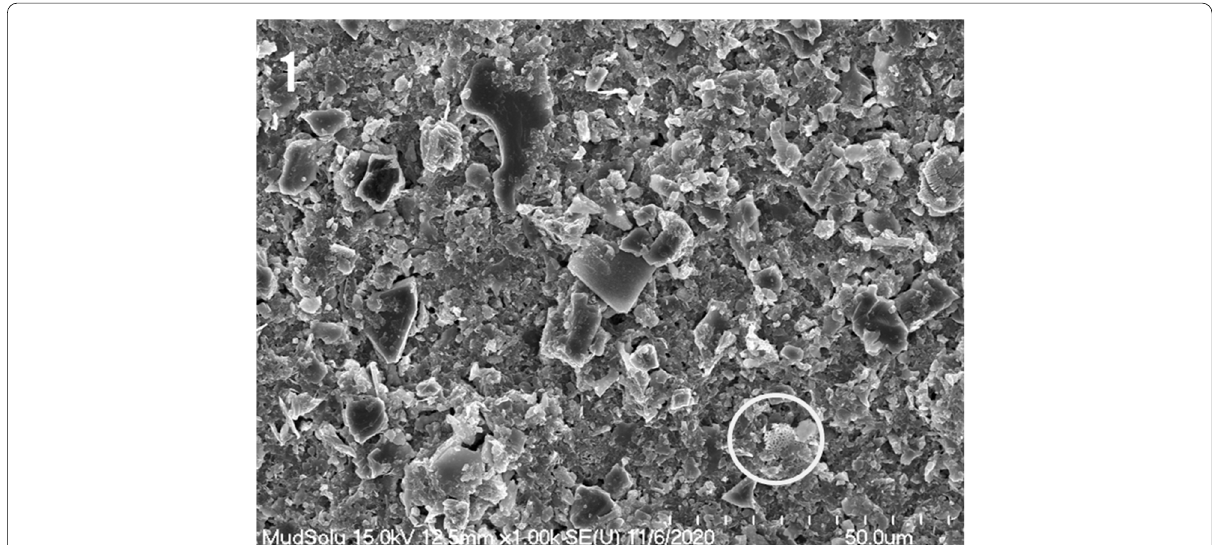
Fig. 1 A scanning electron micrograph of mud precipitation depicting microorganism remnants (circle)